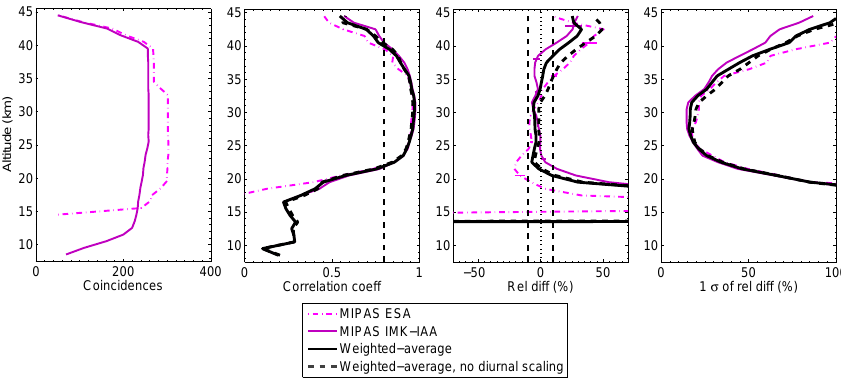
Figure 14. Morning N 2 O 5 comparisons between ACE-FTS and MIPAS measurements with coincidence criteria of within 3h and 100km. Error bars in the relative difference profiles represent the standard error of the mean. Table 4. Summary of validated ACE-FTS NO y systematic differences for two different cases. Case 1: region where the weighted-average correlation coefficient profile is greater than 0.5 and the weighted-average standard deviation of the relative differences profile is less than 100%. Case 2: region where the weighted-average correlation coefficient profile is greater than 0.8 and the weighted-average standard deviation of the relative differences profile is less than 50%. Results are for comparisons using all data and the species-dependent optimized coincidence criteria (given in text and Table